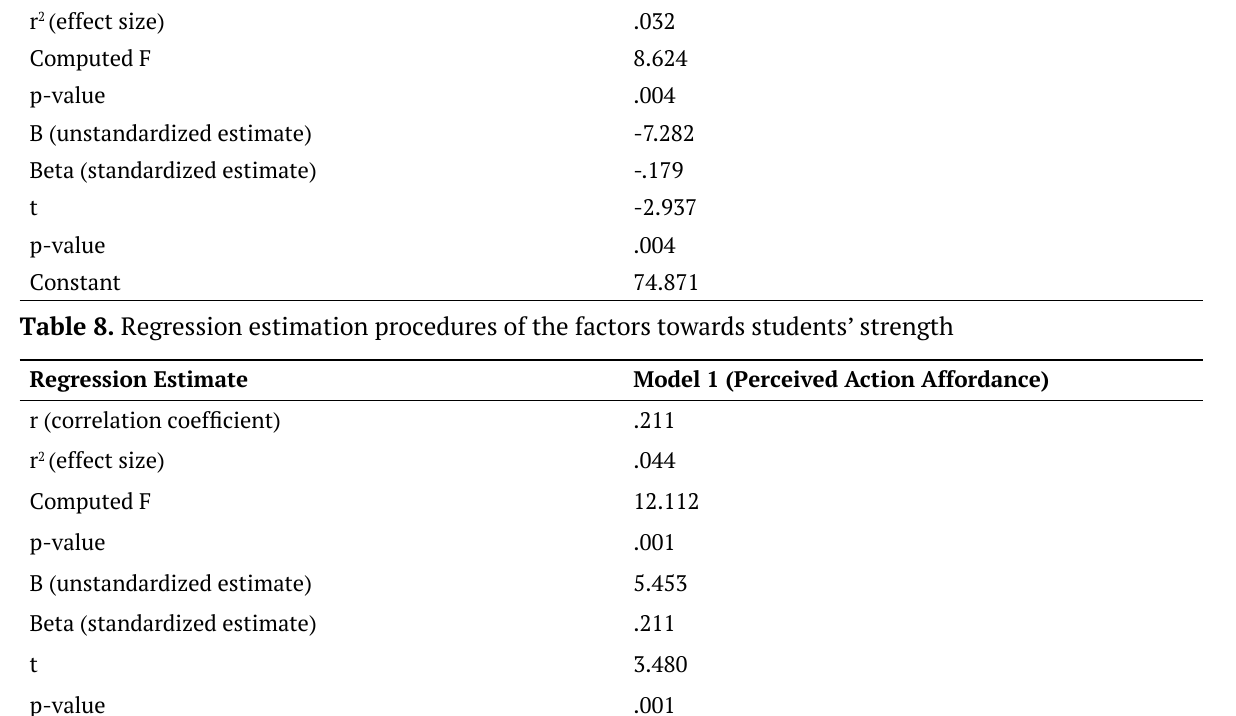
Table 7. Regression estimation procedures of the factors towards students’ flexibility Regression Estimate